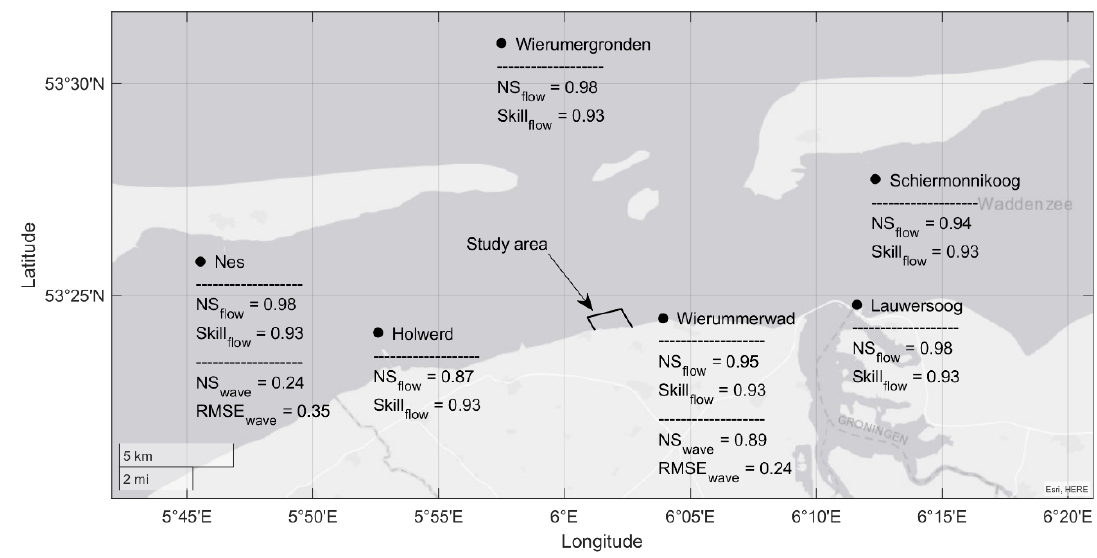
Figure 6. Validation of the hydrodynamics for all measurement stations within the model domain for which data are available. This is performed for the Nash Sutcliffe coefficient (NS) and index of agreement (Skill) for validation of the water levels in the flow module (flow). Similarly, it is performed for the NS and the root mean square error (RMSE) for the significant wave heights in the wave module (wave).